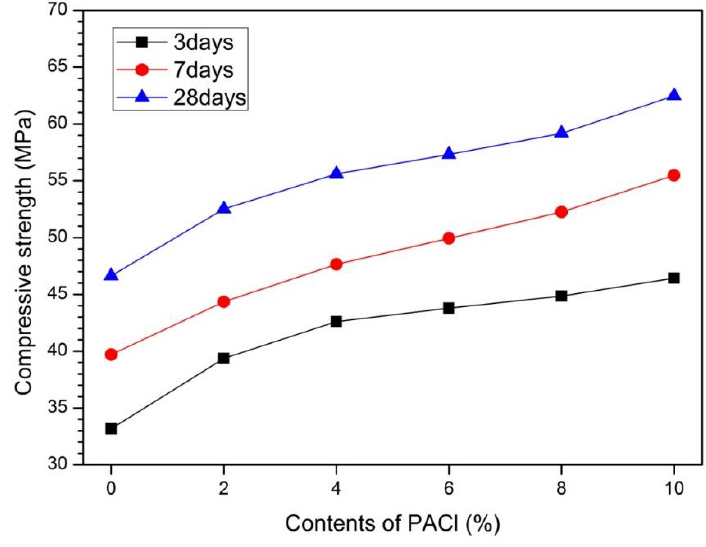
Figure 3. Compressive strength of PACl-added OPC as function of PACl content.